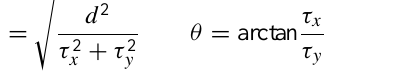
Fig. 2. EISCAT data from 25 November 2003, showing (a) electron density, (b) electron temperature, (c) ion temperature, and (d) ion velocity. A wavefront of a gravity wave in electron density is shown with a dashed